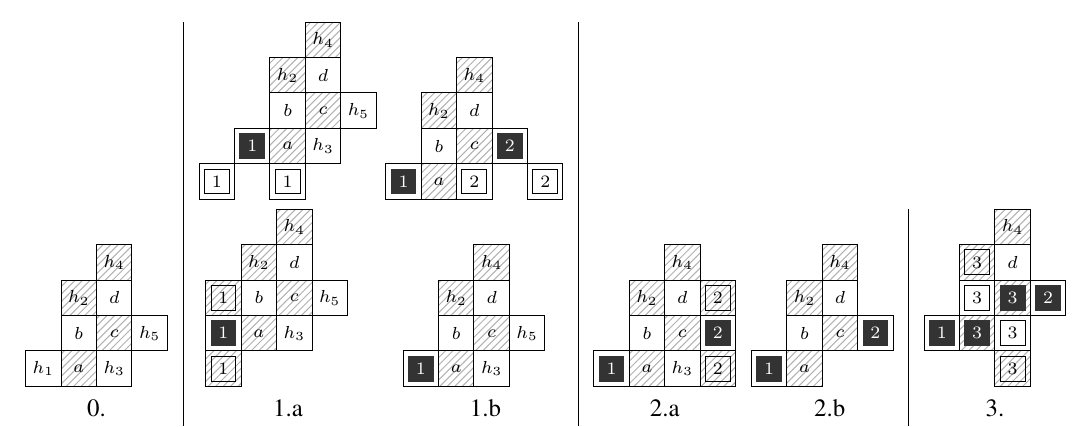
Figure 25: A failing attempt of the maker to use a move sequence starting with the moves h 1 , h 5 , ac, . . . in a placement of the goal